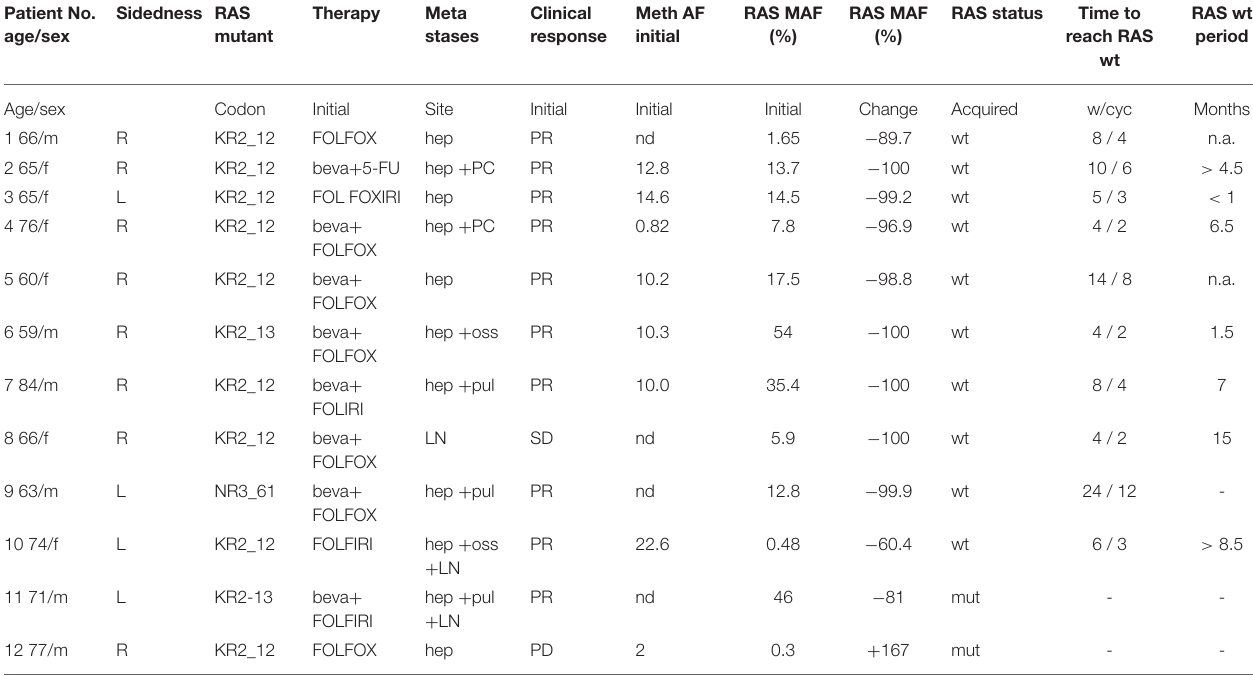
TABLE 1 | Patient baseline characteristics and dynamics of mutations in liquid biopsy. Patient No. Sidedness RAS Therapy Meta Clinical age/sex mutant stases response